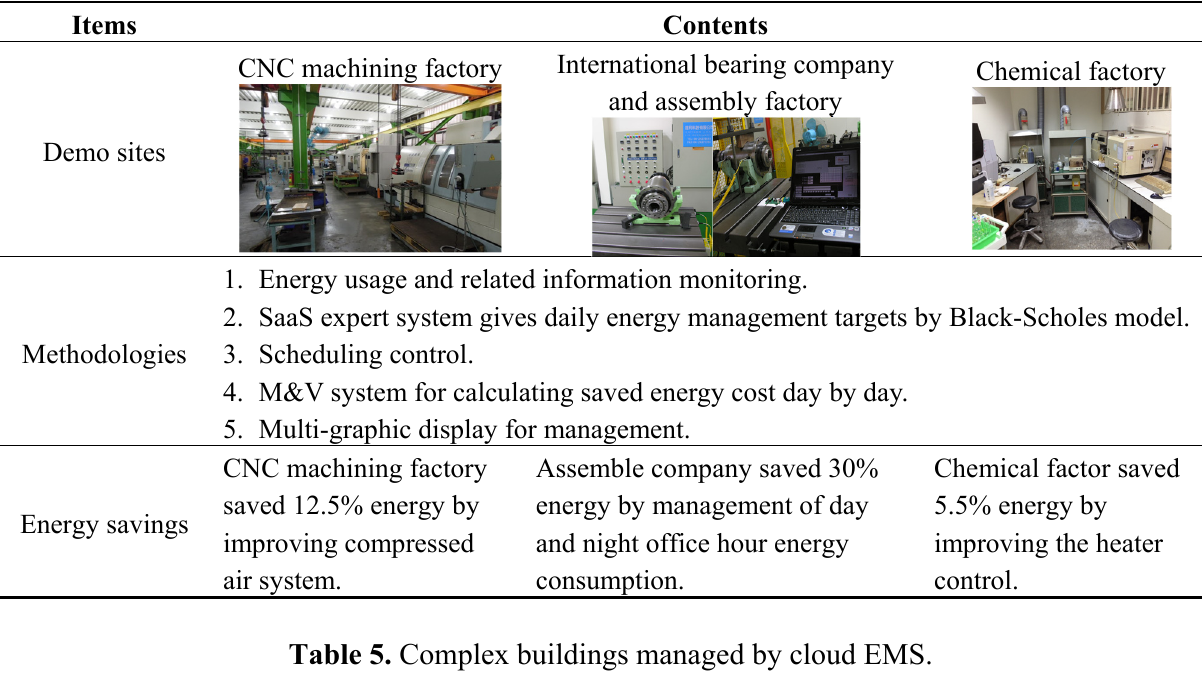
Table 4. Factories managed by cloud EMS.